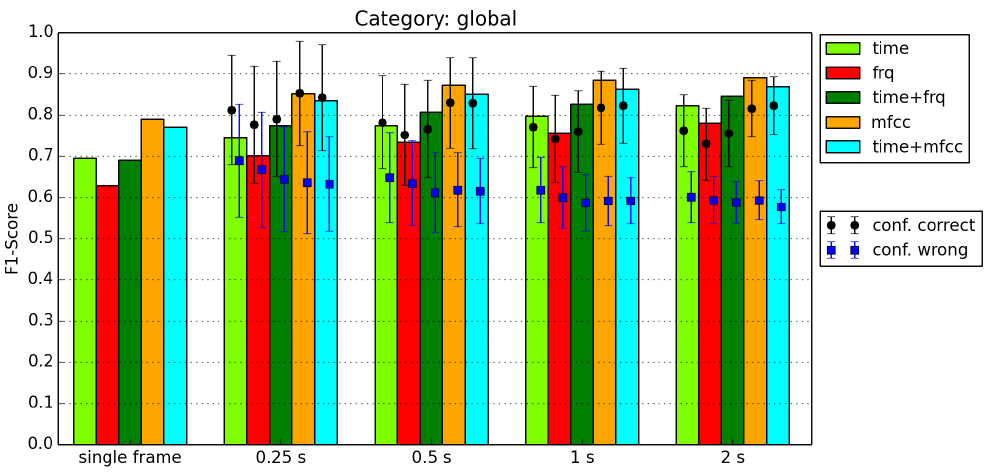
Figure 6. Classification of category Global.